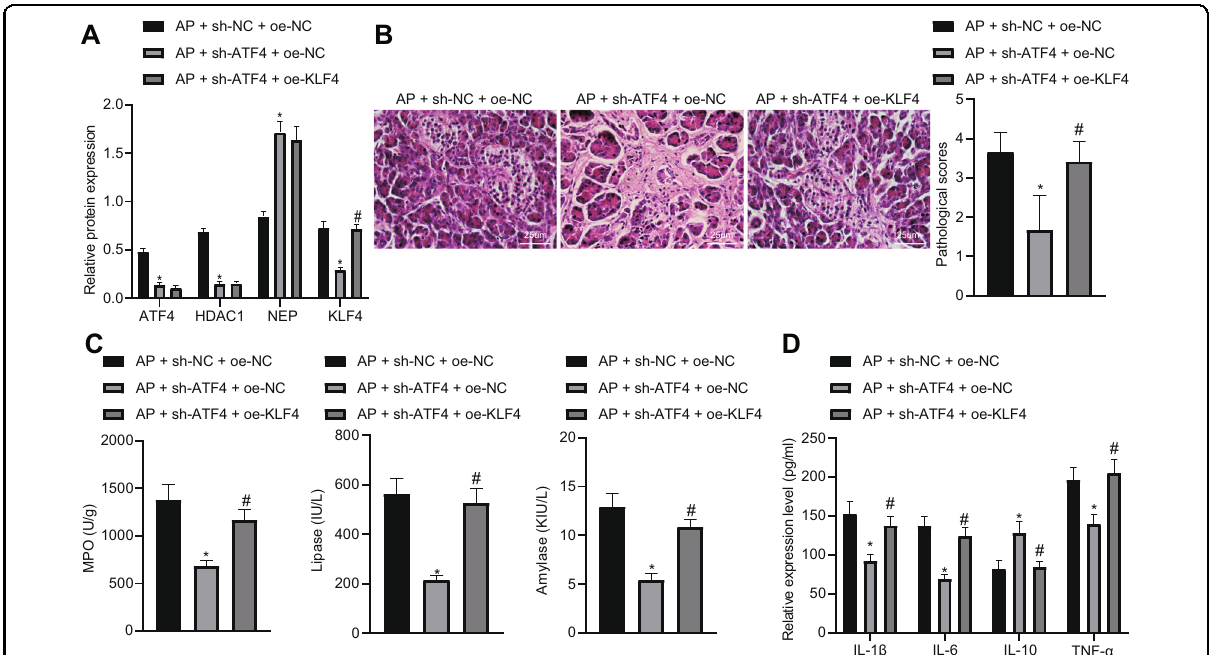
Fig. 8 Downregulation of ATF4 suppresses AP via regulation of NEP-KLF4 expression by inhibiting HDAC1. A Western blot analysis was performed to detect ATF4, HDAC1, NEP, and KLF4. B HE staining to detect pathological conditions of pancreatic tissue after sh-ATF4 or oe-KLF4 treatment in AP mice. C Biochemical analysis to detect peroxidase, serum amylase, and serum lipase levels after sh-ATF4 or oe-KLF4 treatment in AP mice. D ELISA to detect serum IL-1 β , IL-6, IL-10, and TNF- α in AP mice; * p < 0.05 compared with the AP + sh-NC + oe-NC group; # p < 0.05 com p ared with the AP + sh-ATF4 + oe-NC group. The comparison of the measurement data (mean standard ± deviation) among multiple groups was analyzed by one-way analysis of variance with Tukey ’ s post hoc